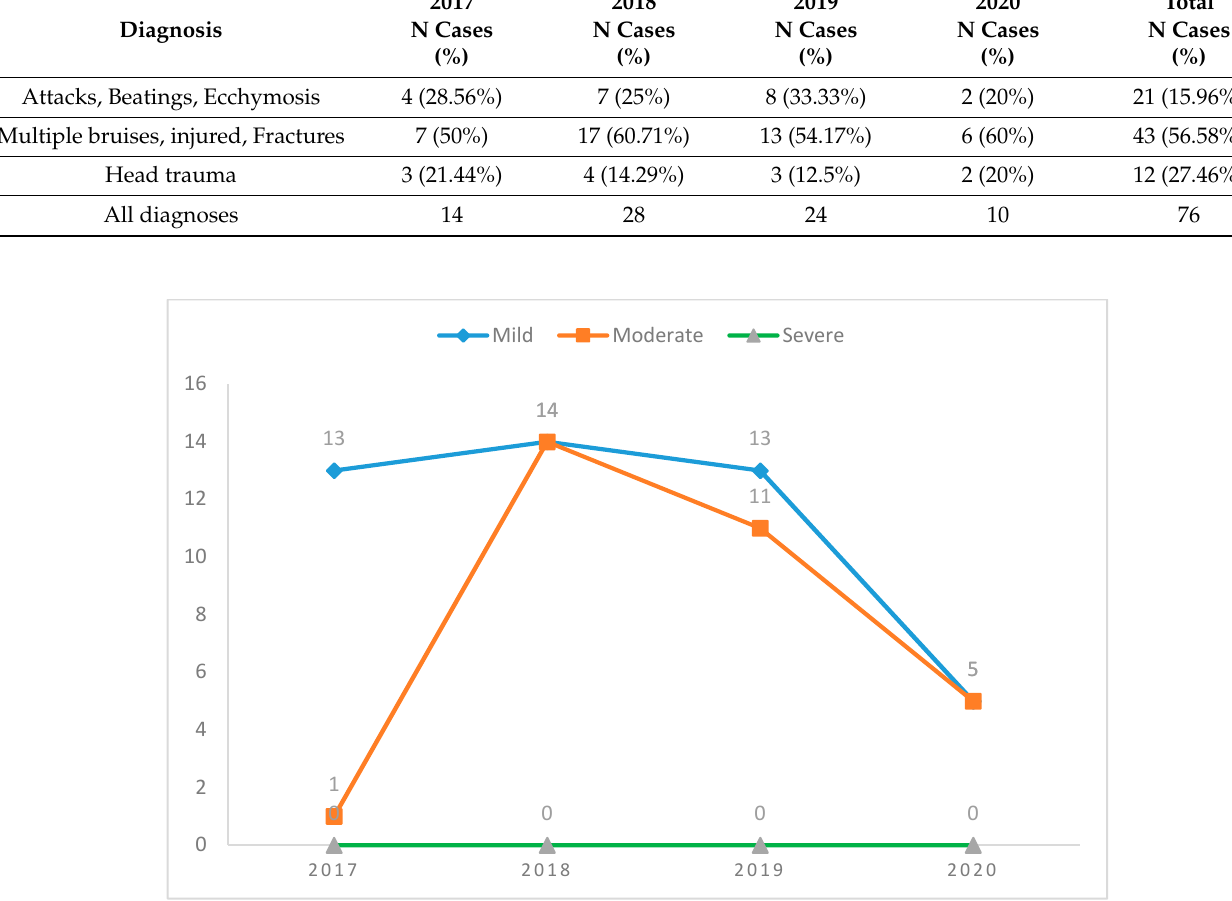
Table 1. Statistical data relating to cases of violence against women found in the medical records analyzed.